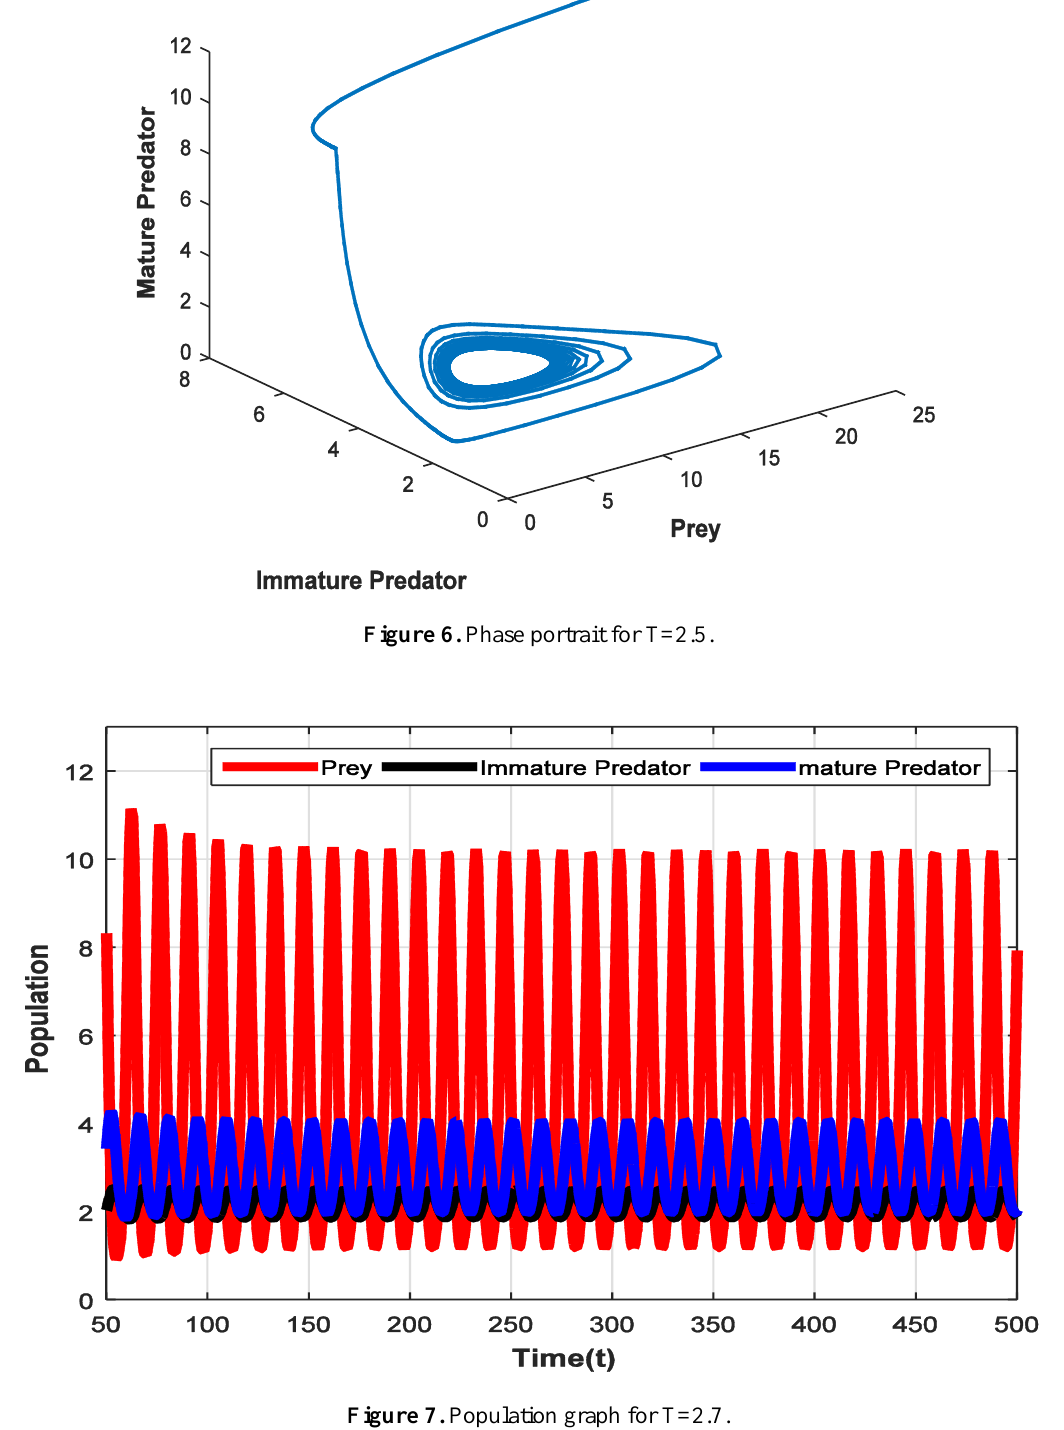
Figure 7. Population graph for